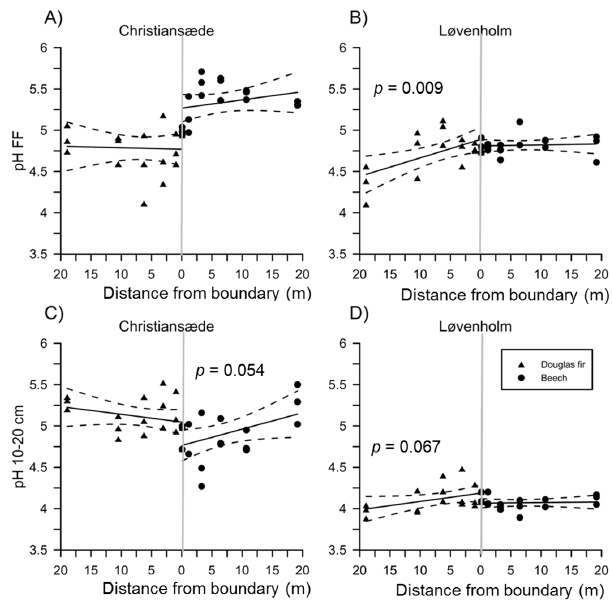
Figure 5. Response of the soil pH in the forest floor ( A and B ) and 10–20 cm layer ( C and D ) along transects from pure Douglas-fir and beech stand conditions to the boundary at Christianssæde and Løvenholm.